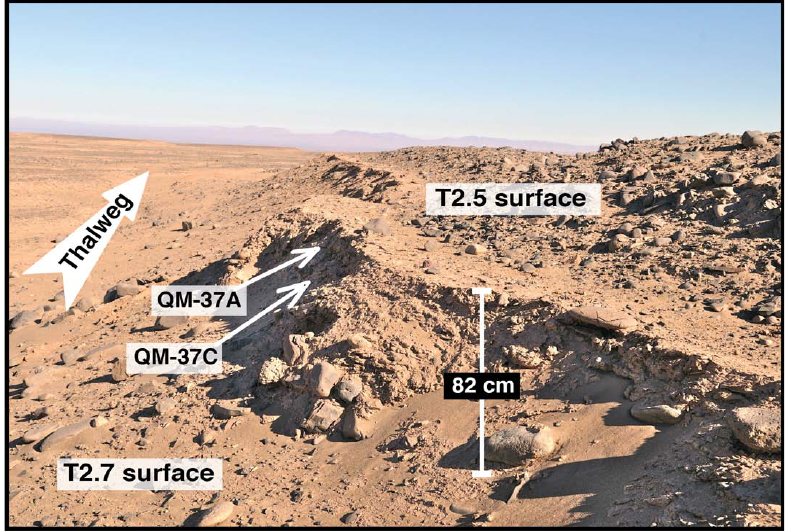
Fig. A7. Perched irrigation channel. The provenance of samples QM-37C and QM-37A is shown.